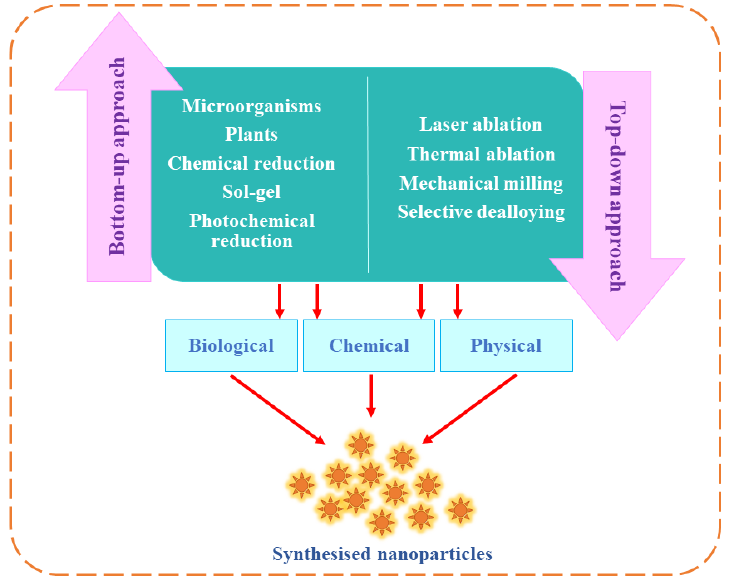
Figure 3. Biological, chemical, and physical methods of NP synthesis are categorized as bottom-up and top-down approaches.